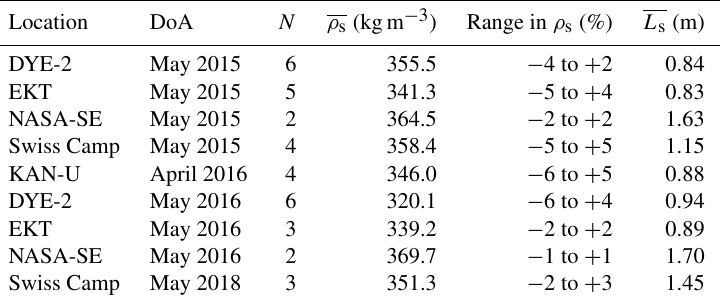
Table 2. Locations of snow density analyses with date of acquisition (DoA), number of snow pits ( N ), mean density ( ρ s ), density ( ρ s ) range as a percent of mean ρ s and mean snow depth ( L s